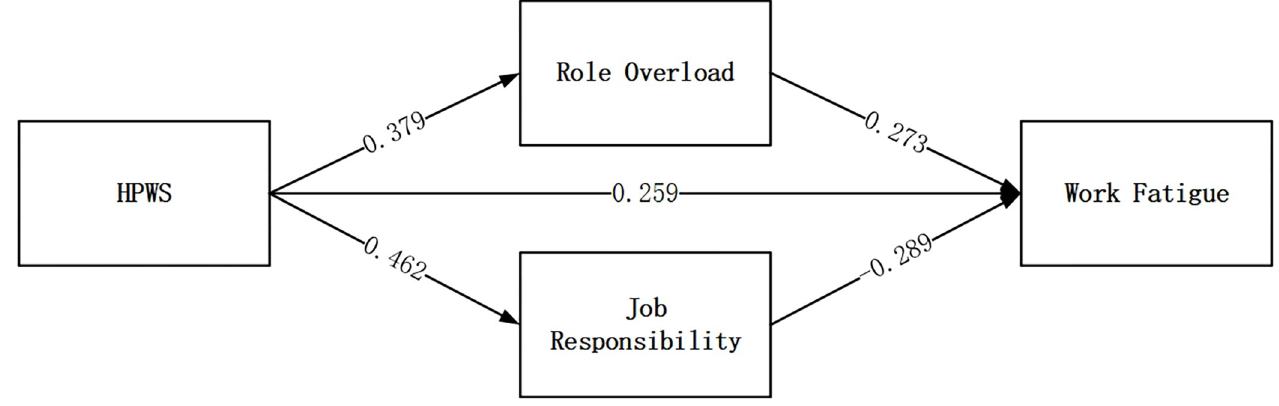
In this study, Mplus 8.3 is used for path analysis of data, and the path analysis result is shown in Fig 1. H1 proposed that HPWS has a positive effect on work fatigue through role overload. As shown in Fig 1, HPWS has a positive influence on role overload (beta = 0.379, P < 0.05), which means that role overload continuously increases with the HPWS increase. Fur-